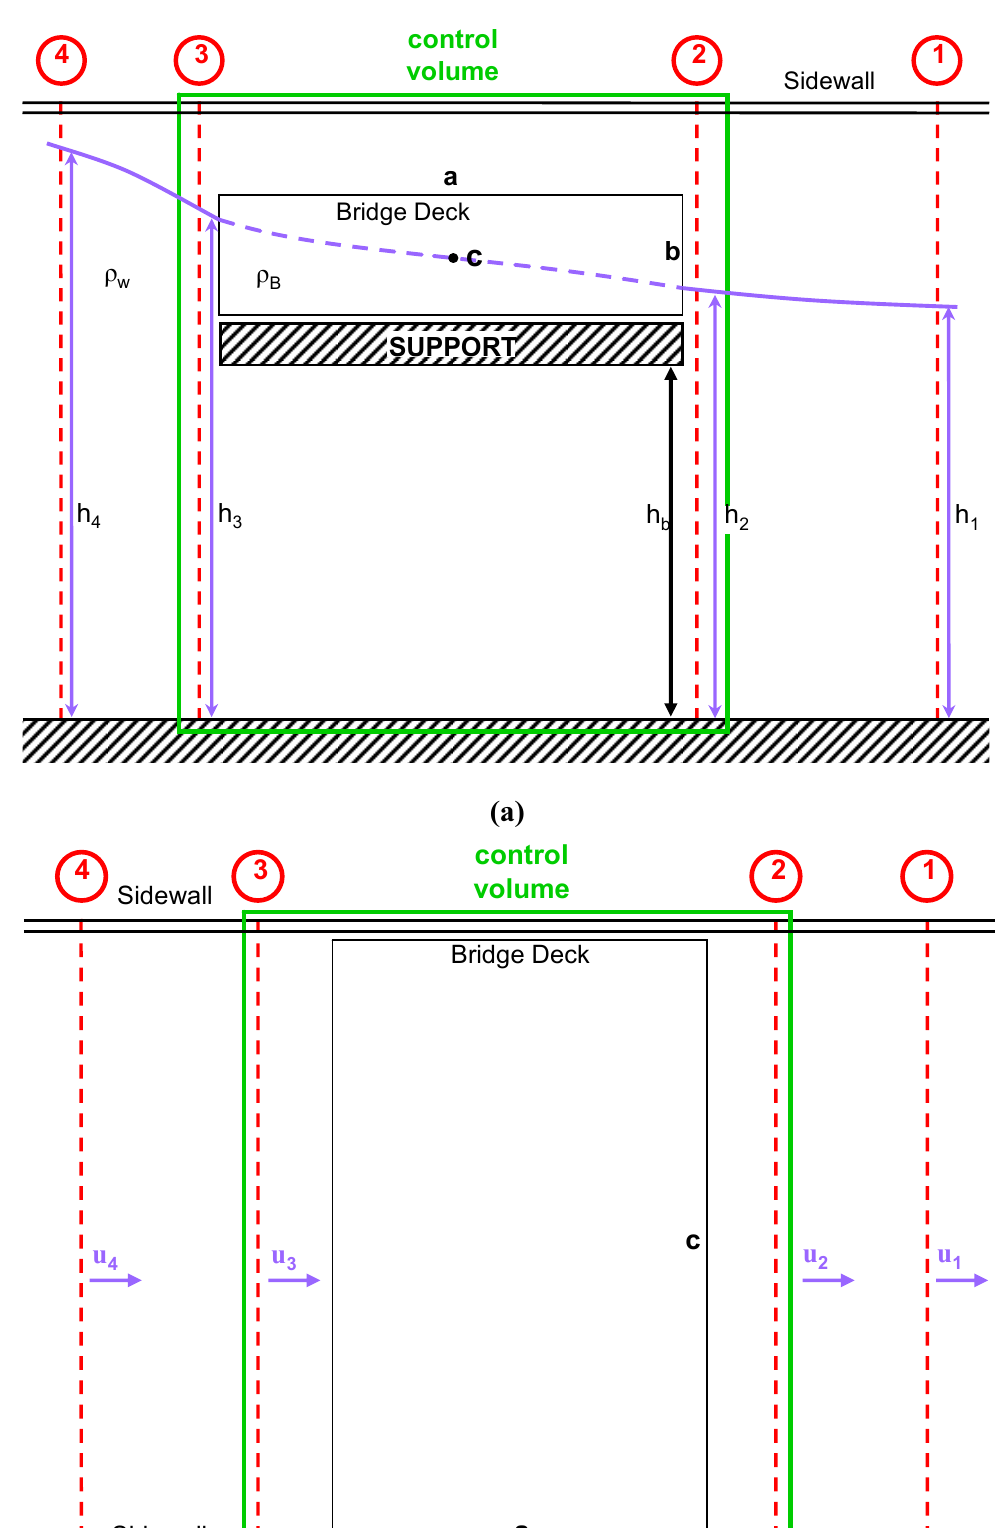
Figure 2. Prospects of the bridge: hydrodynamic and geometrical parameters, necessary idealizations and definition of the control volume. ( a ) side view; ( b ) top down view; ( c ) font view; ( d ) control